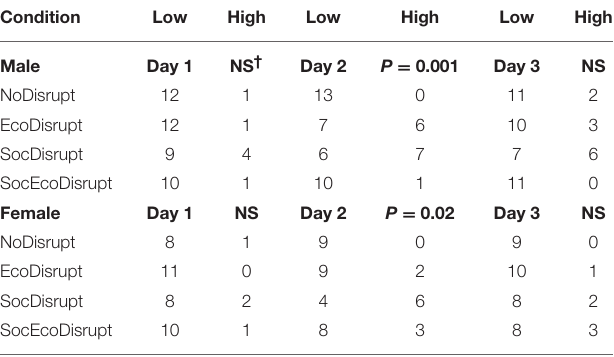
TABLE 3 | Frequency of excretion by Singly-housed (Isolate) subjects in the open-field arena.